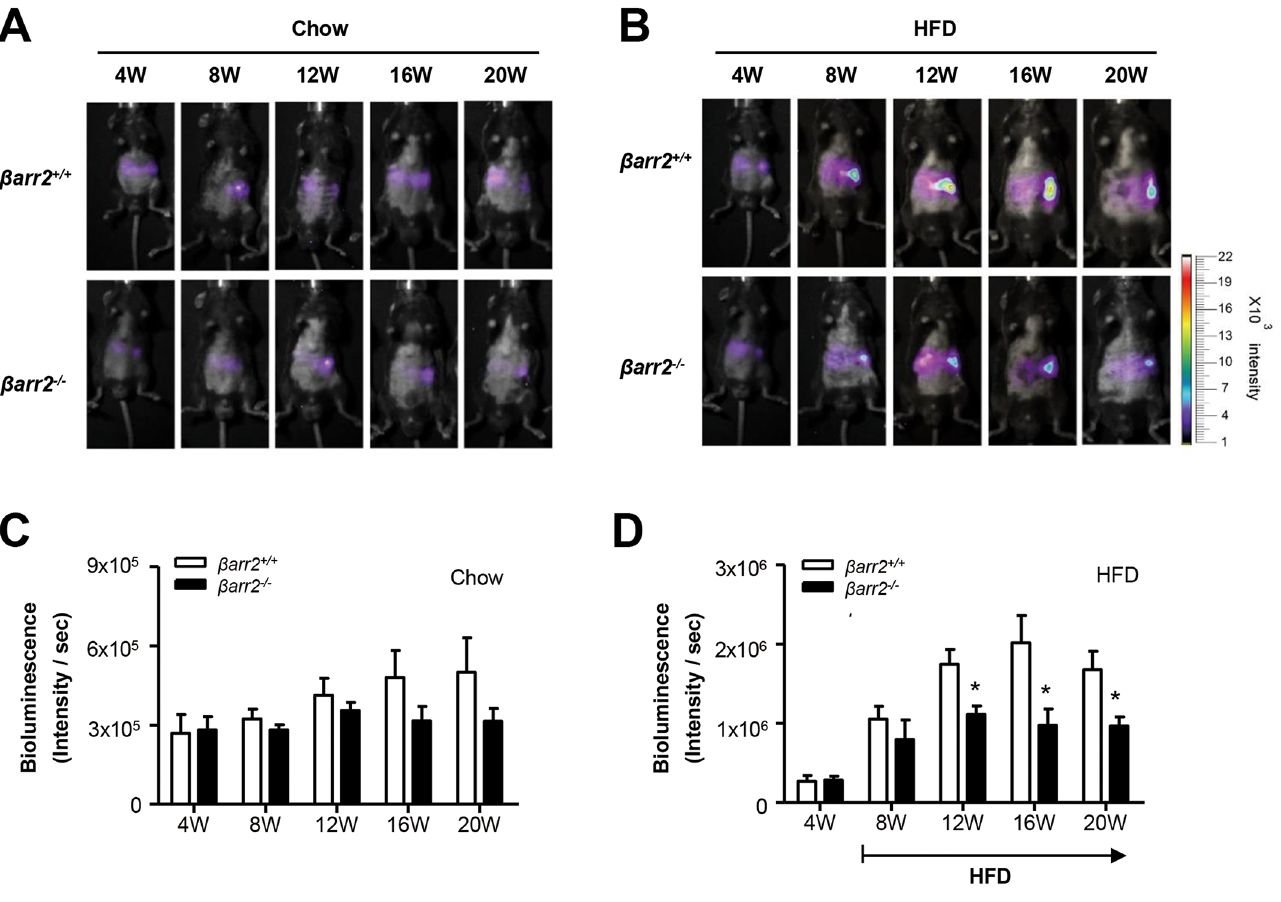
Figure 2. Dynamic changes of β -cell mass in MIP-TF- b arr2 –/– mice. (A, B) MIP-TF- b arr2 +/+ and MIP-TF- b arr2 –/– mice fed either (A) a chow diet or (B) a HFD were imaged at 4, 8, 12, 16 and 20 wks. Representative bioluminescence images of MIP-TF- b arr2 +/+ and MIP-TF- b arr2 –/– mice are shown. (C, D) Quantification of signal intensity corresponding to the pancreatic area in MIP-TF- b arr2 +/+ and MIP-TF- b arr2 –/– mice (n = 4–6). * P < 0.05 versus MIP-TF- b arr2 +/+